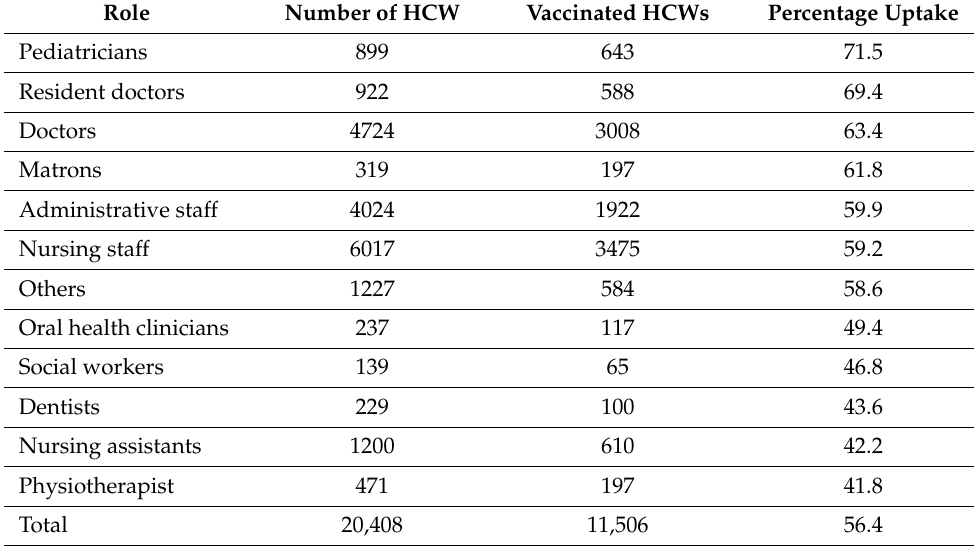
Table 2. Flu vaccination uptake in primary care by role.